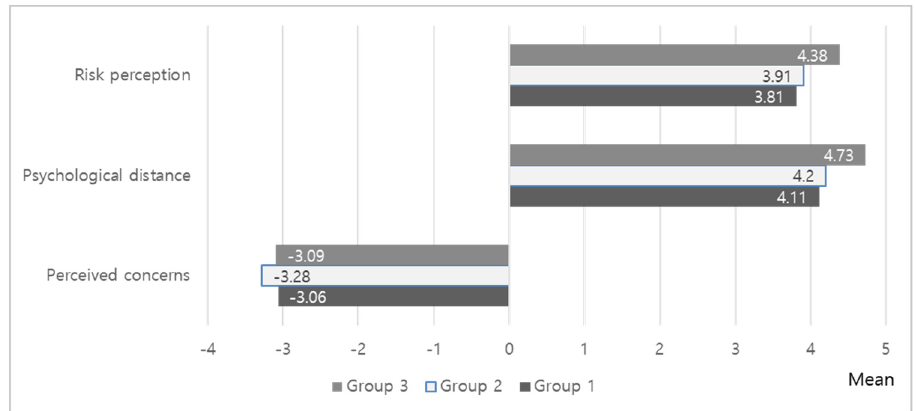
Figure 7. Residents’ psychological influences.